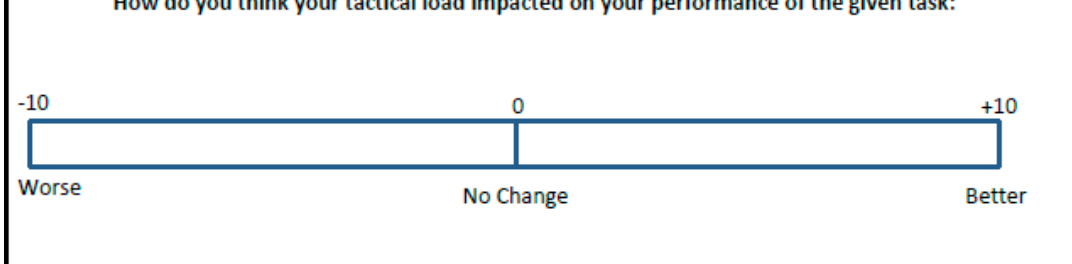
Figure 1. Task-performance impact scoring sheet.